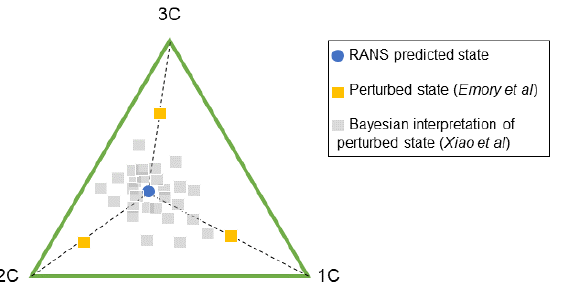
Figure 7. Barycentric map of the physically realisable states of turbulence as a combination of three limiting states of turbulence: one, two, and three components (1C, 2C, and 3C, respectively) and represented the perspectives for pertubation based and Bayesian based methods of UQ in this space. Adapted from [67,76]. Copyright 2016 Elsevier B.V.